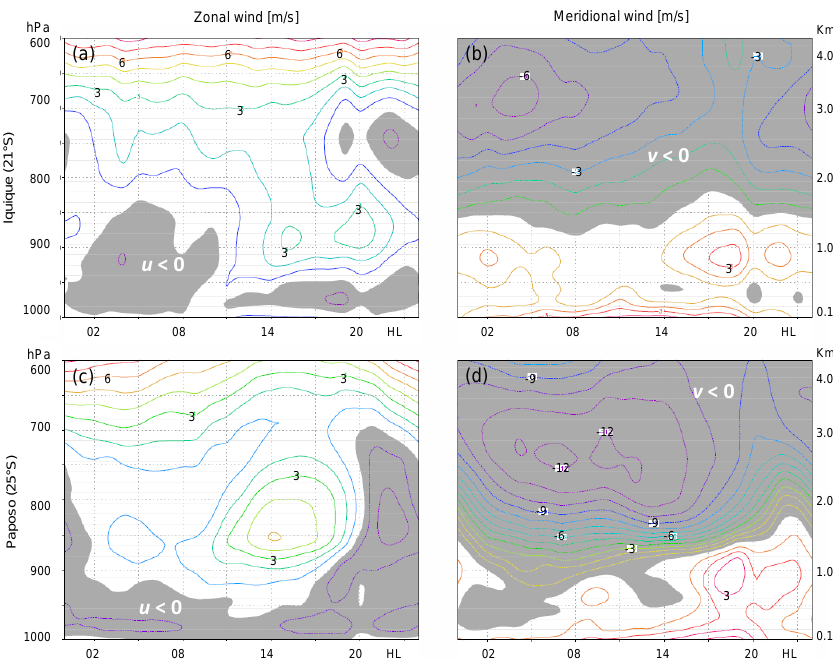
Fig. 7. WRF-simulated 4-day mean diurnal cycles at a coastal column at 21 ◦ S (near Iquique, upper panels) and 25 ◦ S (near Paposo, lower panels). Left panels: zonal wind component (1ms − 1 contours; the zero line is omitted and easterly flow in light gray). Right panels: merid- ional wind component (1ms − 1 contours; the zero line is omitted and northerly flow in light